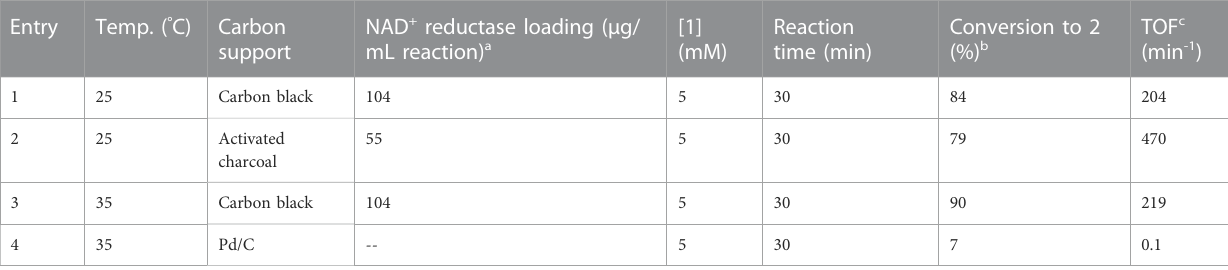
TABLE 2 Effect of varying different parameters on the rate of conversion of 1 in batch